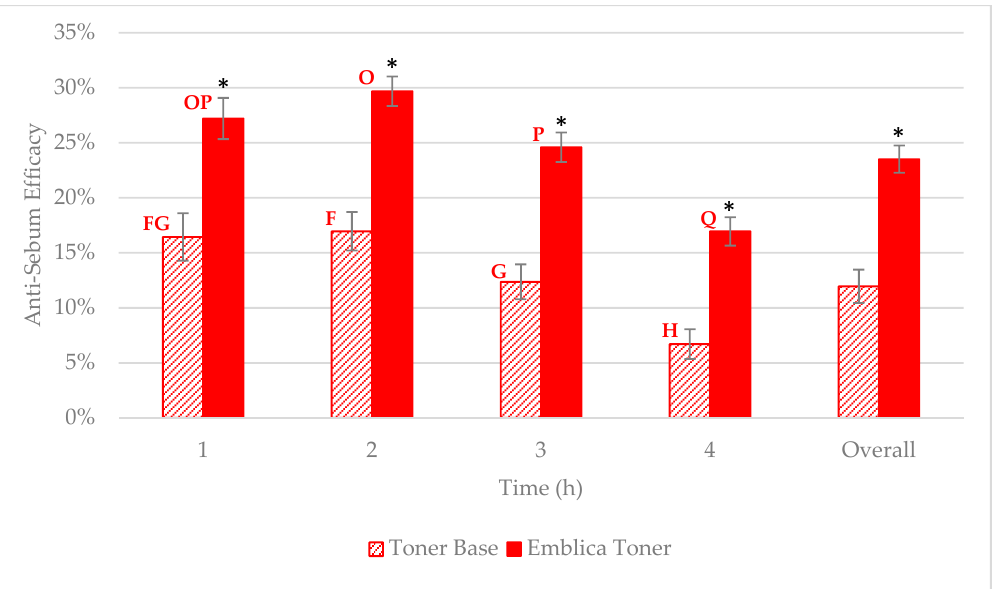
Figure 8. Anti-sebum efficacy of the emblica toners of treatment compared with the toner base at different periods of 30 volunteers. * indicates statistically significant differences between the average anti-sebum efficacy of emblica toner and that of toner base in the same period ( p < 0.05). Different capital letters ( F,G,H ) indicate statistically significant differences ( p < 0.05) in the treatment with the toner base between periods of 1, 2, 3 and 4 h. Different capital letters ( O,P,Q ) indicate statistically significant differences ( p < 0.05) in the treatment with the emblica toner between periods of 1, 2, 3 and 4 h.